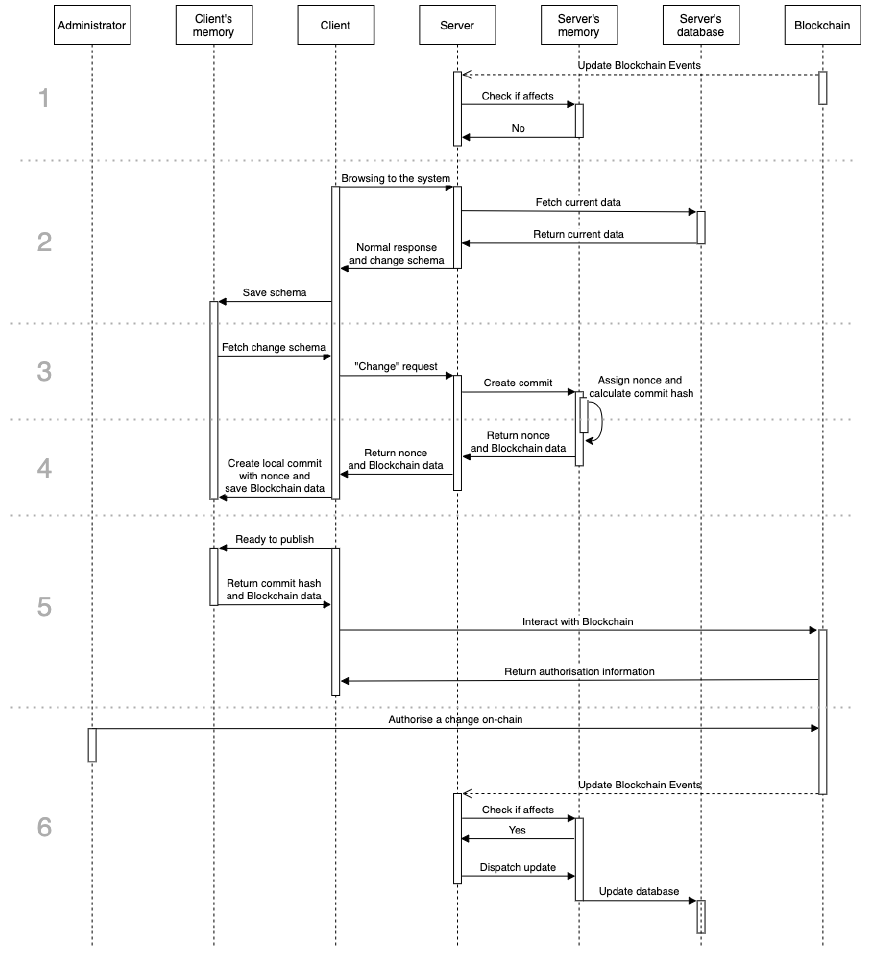
Figure 1. Flow diagram of the proposed